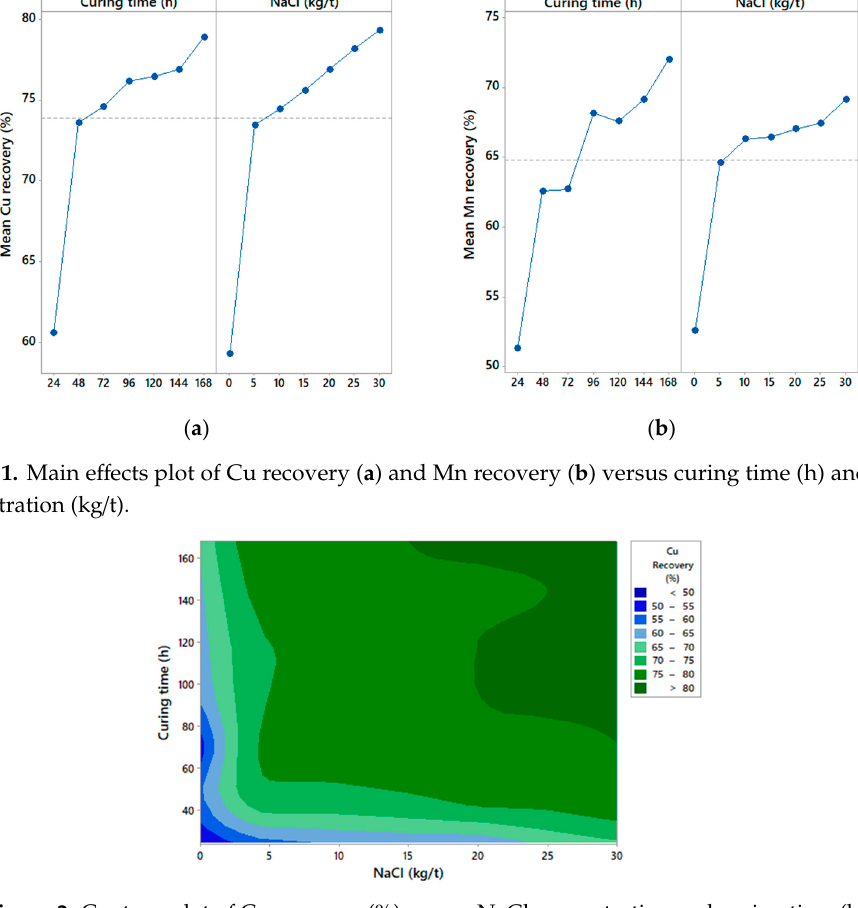
Figure 2. Contour plot of Cu recovery (%) versus NaCl concentration and curing time (h).